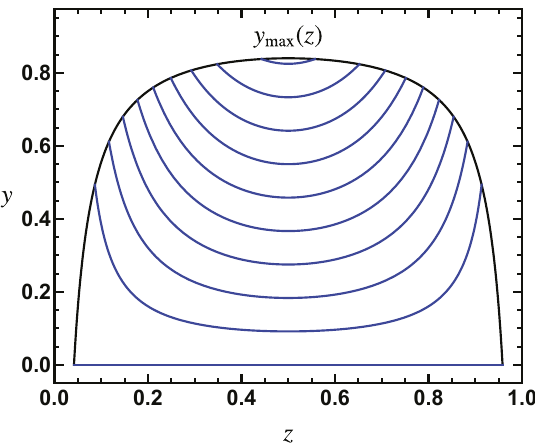
Figure 6 . Phase space diagram in ( z; y ) coordinates (black lines) showing curves with constant value of the C-parameter measurement function in the soft limit C (blue lines) with ^ m = 0 : 2. The lines correspond to 10 equally spaced values of C between 0 and 0 : 681. For the event shape maximal value C max = v 2 f C (1 = 2), the corresponding contour line intersects with the phase space boundary at one point only, the maximum (1 = 2 ; v 2